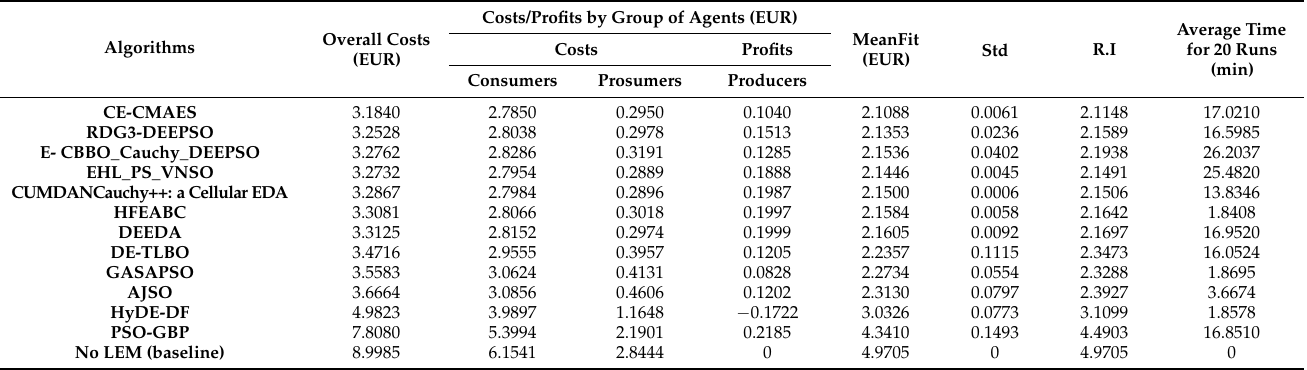
Table 3. Overall costs/profits, mean fitness, standard deviation, execution time and R.I achieved by the tested